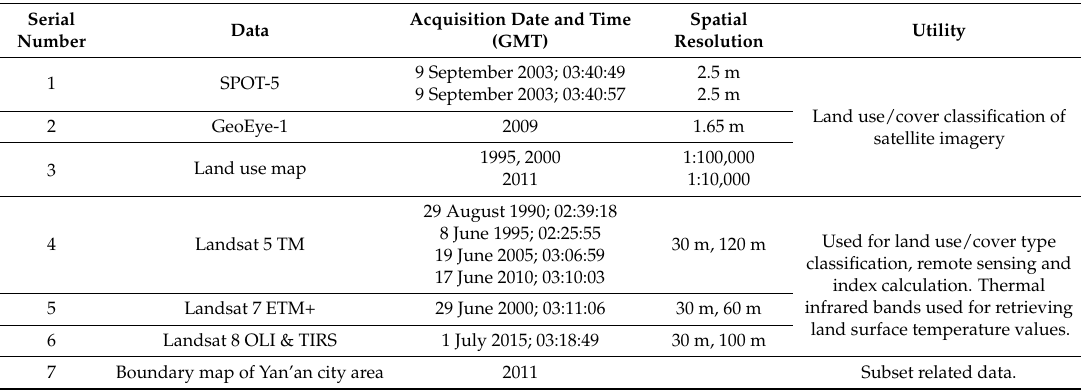
Table 1. Overview of the data used in this